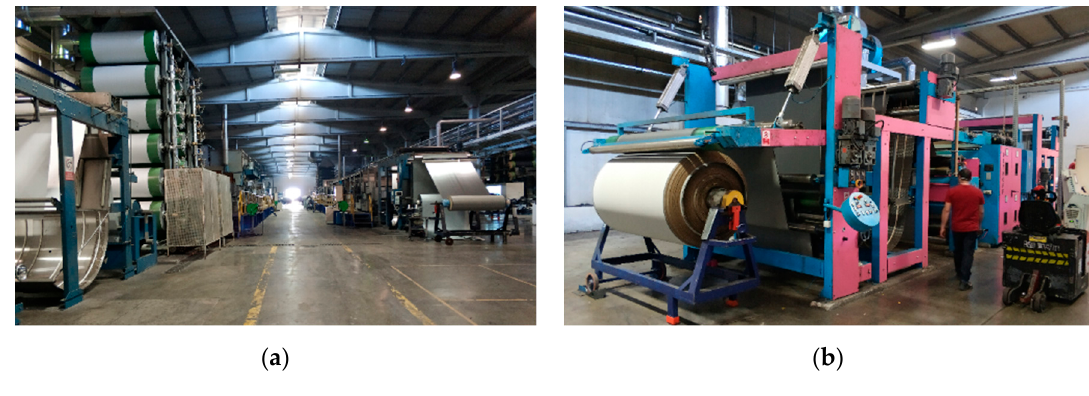
Figure 2. ( a ) Navigation corridor, ( b ) Finishing machine.